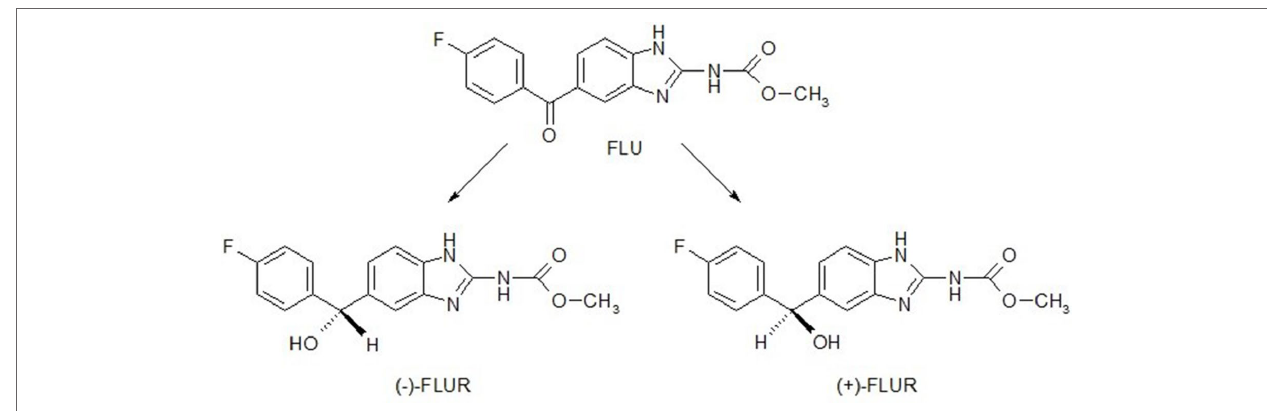
FIGURE 1 | Structural formulae of flubendazole (FLU) and enantiomers of its reduced metabolite FLUR, (+)-FLUR enantiomer and (−)-FLUR